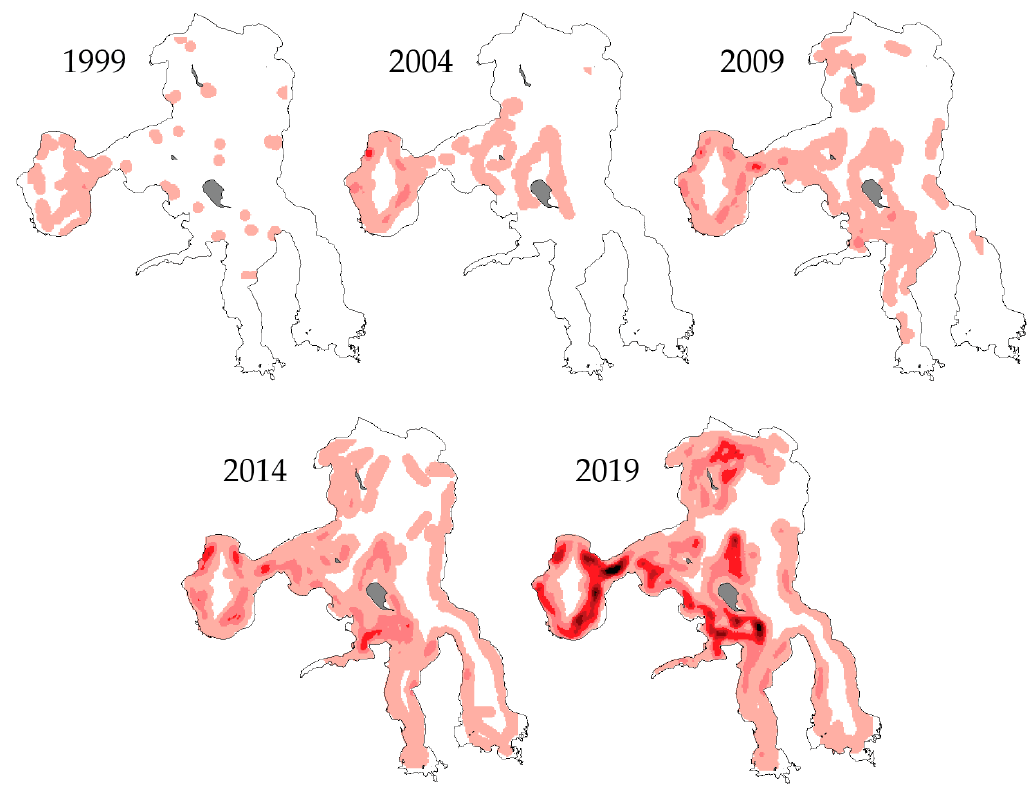
Figure 7. Spatial expansion and increase in intensity of suppression gillnetting effort on Yellowstone Lake during years of rapid lake trout population growth (1999, 2004, and 2009) and years where distribution of gillnets and overall effort was great enough to curtail population growth (i.e., λ < 1; 2014 and 2019). Darker shades of red indicate lake areas with greater intensity of gillnetting effort.